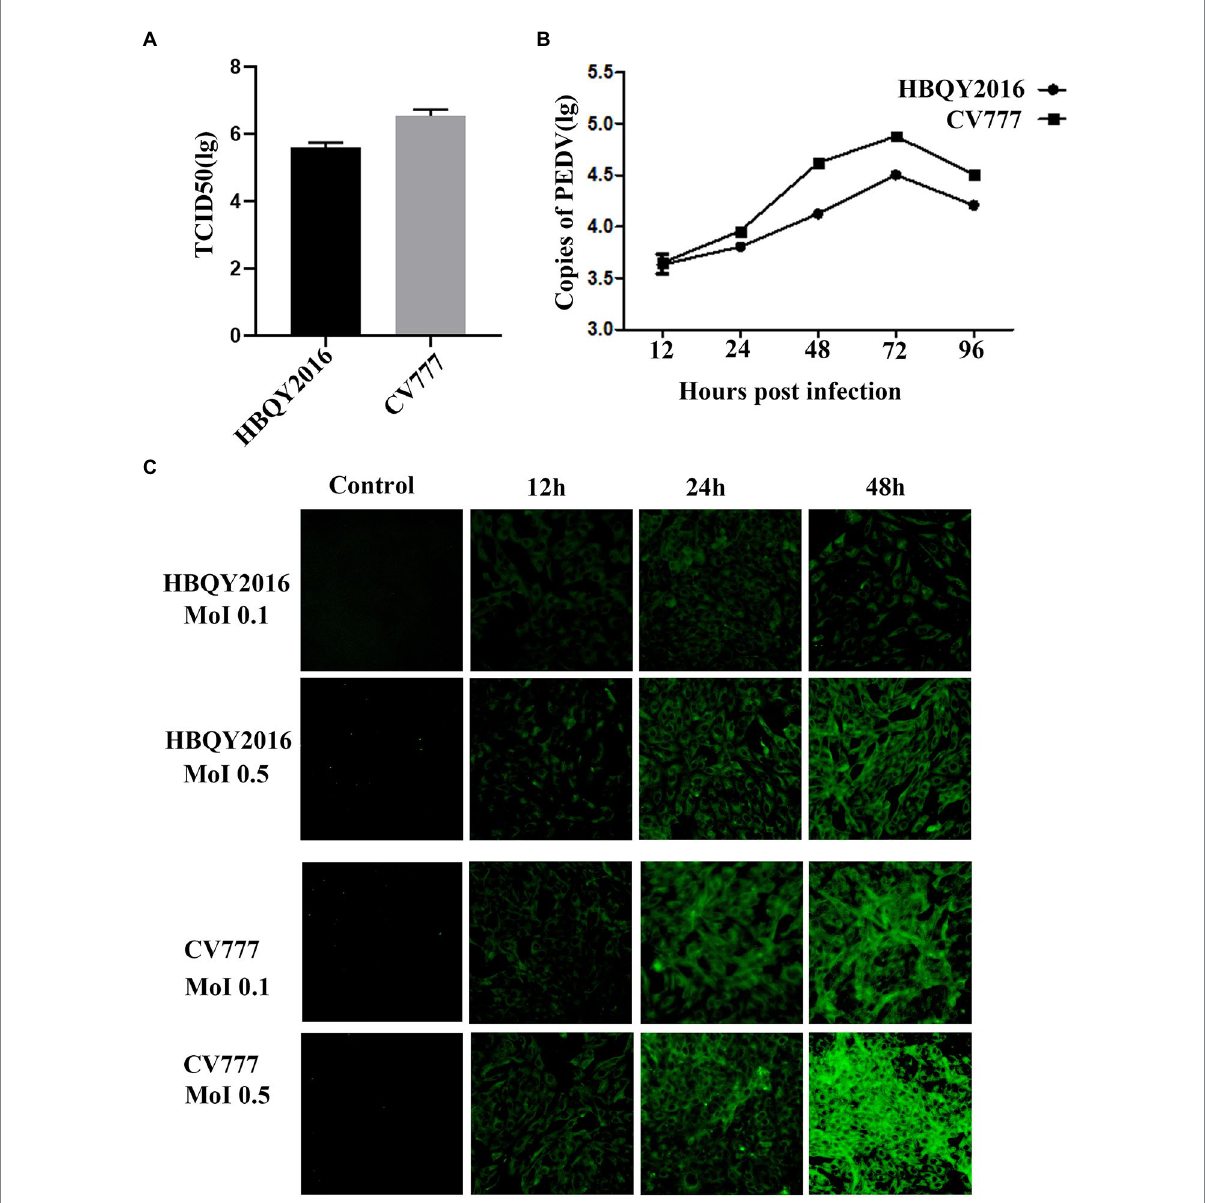
FIGURE 1 Replication of porcine epidemic diarrhea virus (PEDV) in Vero cells. (A) The viral titer of PEDV-HBQY2016 or -CV777 strain was determined with Vero cells with the results expressed as TCID 50 /mL at 72 h post infection (hpi). (B) The copies (Log 10 ) of PEDV-HBQY2016 or PEDV-CV777 strain in Vero cells at different time points was evaluated by RT-qPCR. (C) Immunofluorescence staining of Vero cells infected with PEDV-HBQY2016 or -CV777 strain at different time